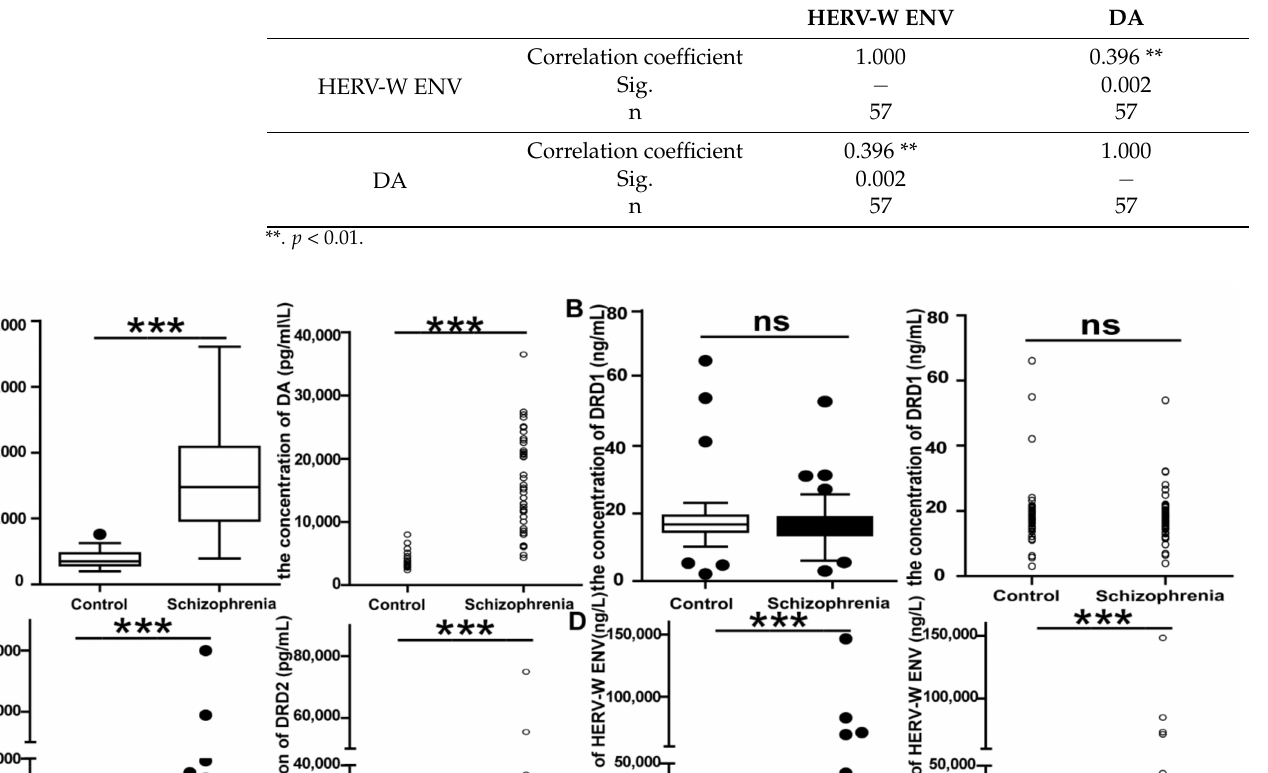
Table 2. The Spearman analysis between HERV-W ENV and DA in schizophrenia patients.